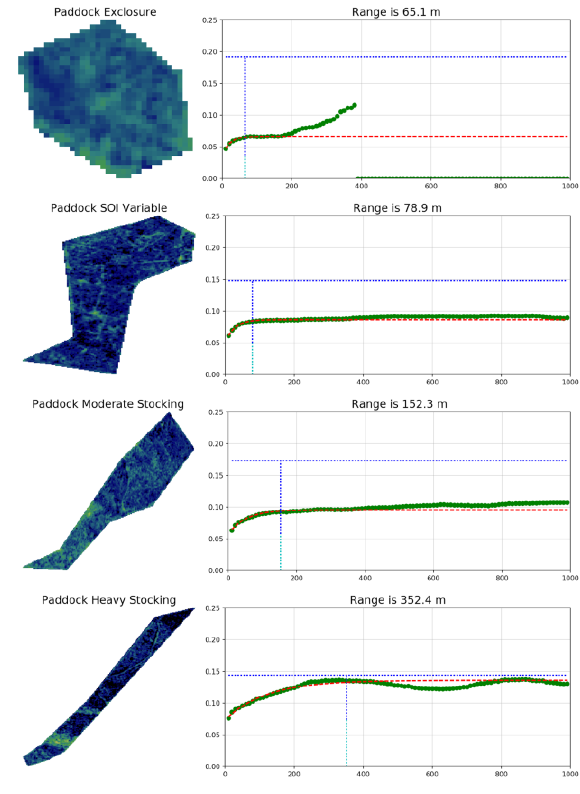
Figure 6. Typical high stocking rate sites. Wamble 13 is high stocking and range is 4.1 m Figure 7. Sentinel 2 bare ground estimates from selected grazing trial paddocks (left images) and computed variograms (right